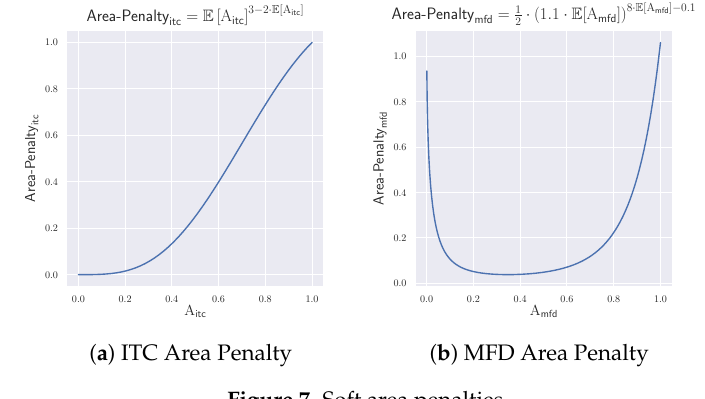
Figure 7. Soft area